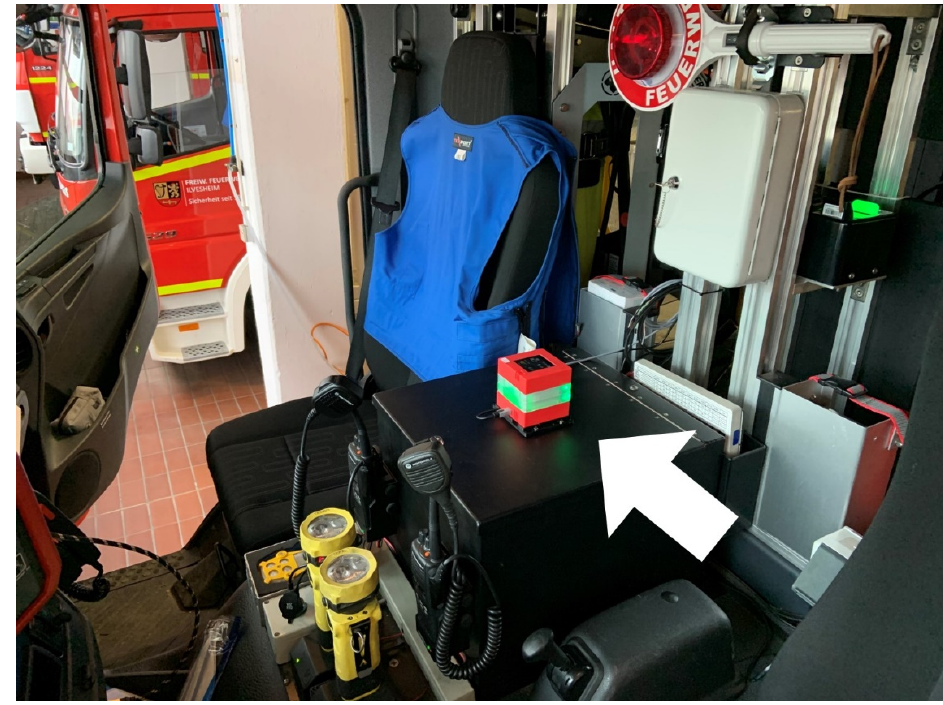
Figure 2. ProxiCube in front area position S1 (white arrow).